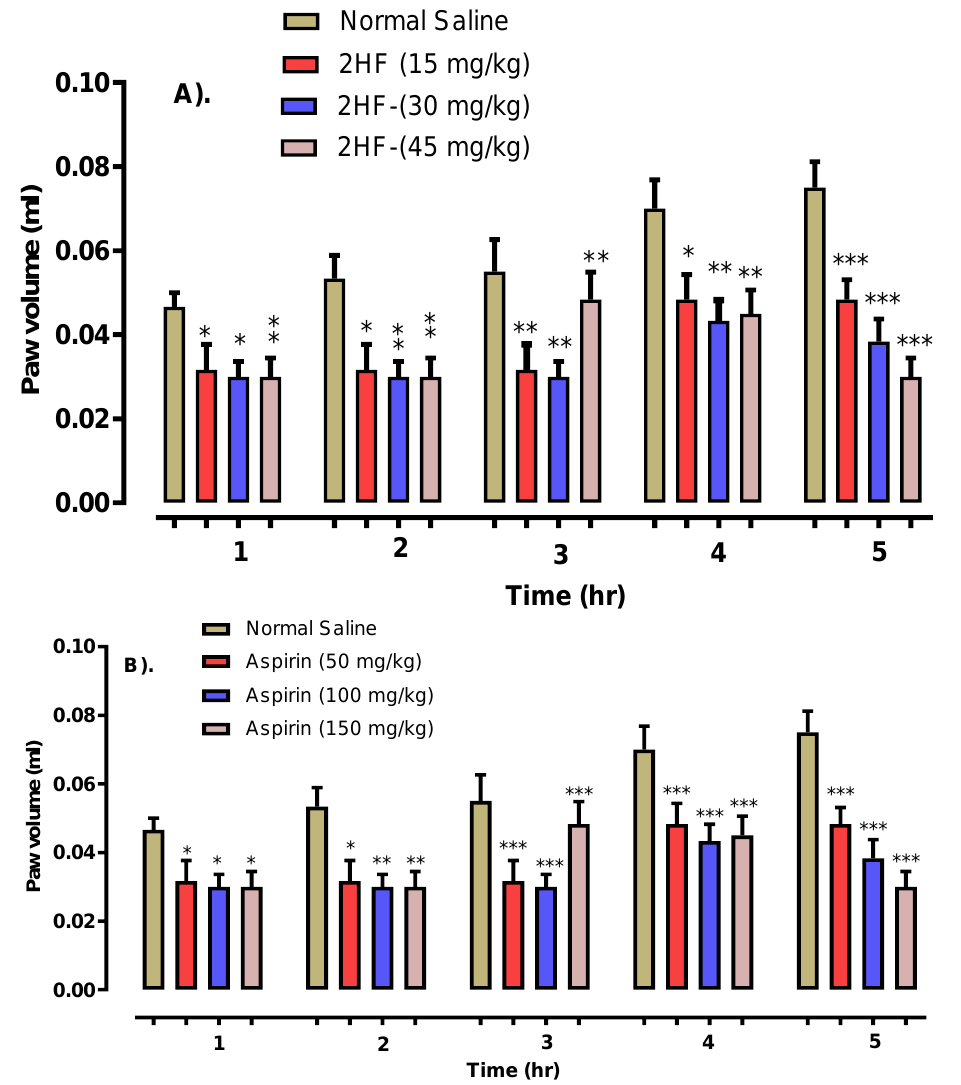
Figure 6. Anti-inflammatory effect of 2-Hydroxyflavanone using carrageenan-induced paw edema model. ( A ). Anti-inflammatory activity of 2HF at 15, 30 and 35 mg/kg dose. ( B ). Anti-inflammatory activity of Aspirin at 50, 100 and 150 mg/kg dose. *** p < 0.001, ** p < 0.01 and * p < 0.05 in comparison to control group, two-way repeated measures ANOVA followed by Tukey’s post hoc test. Histamine showed p < 0.05 after 1 h, p < 0.01 after 3 h and p < 0.001 after 5 h as shown in Figure 7. Serotonin displayed p < 0.05, p < 0.01 and p < 0.001 in 1–2, 3–4, and 5 h intervals respectively as displayed in Figure 8, against that of the saline control group. The 2- HF treated group (30 mg kg − 1 ) saw a reduction in various stages of inflammation response (initial and final stages) which was activated by a carrageenan sub planter injection at 1–3 h. Likewise, a considerable time-dependent decline in histamine and serotonin induced inflammation was observed with 2-HF